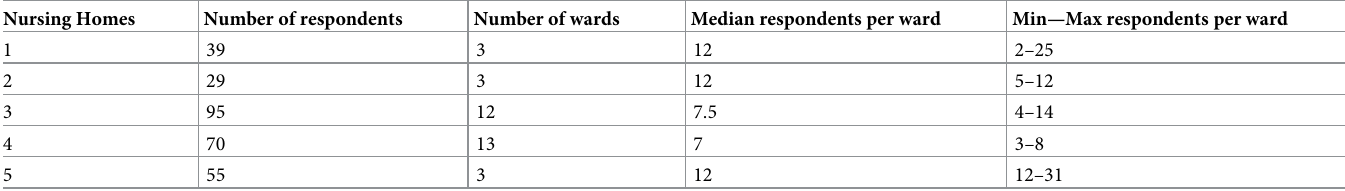
Table 2. Distribution of respondents across wards and nursing